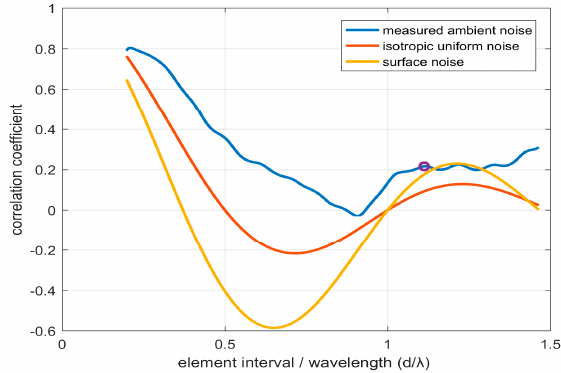
Figure 13. Correlation coe ffi cient of noise with change of d / λ in real ocean noise environment, isotropic noise field and surface noise field.